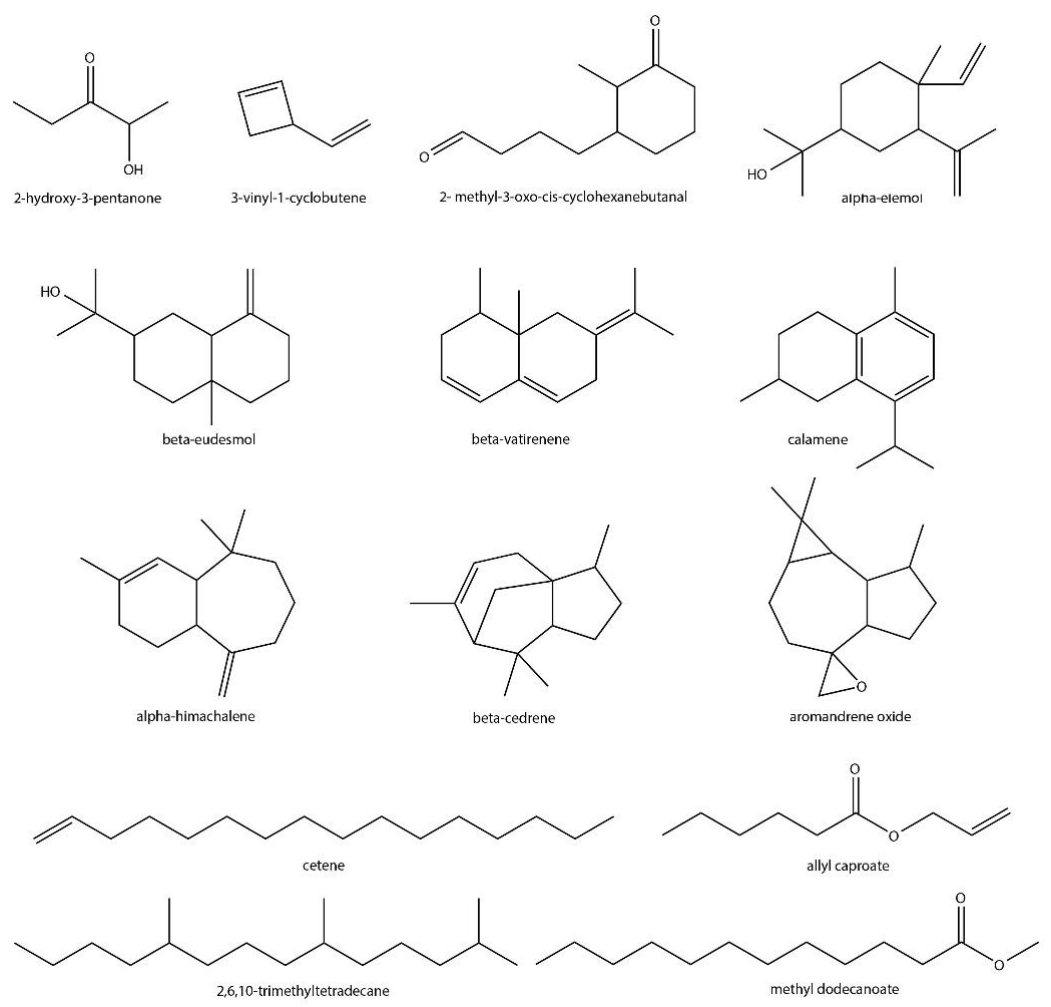
Figure 4. Structures of plant-associated VOCs detected in the current study that have not been previously reported from Streptomyces